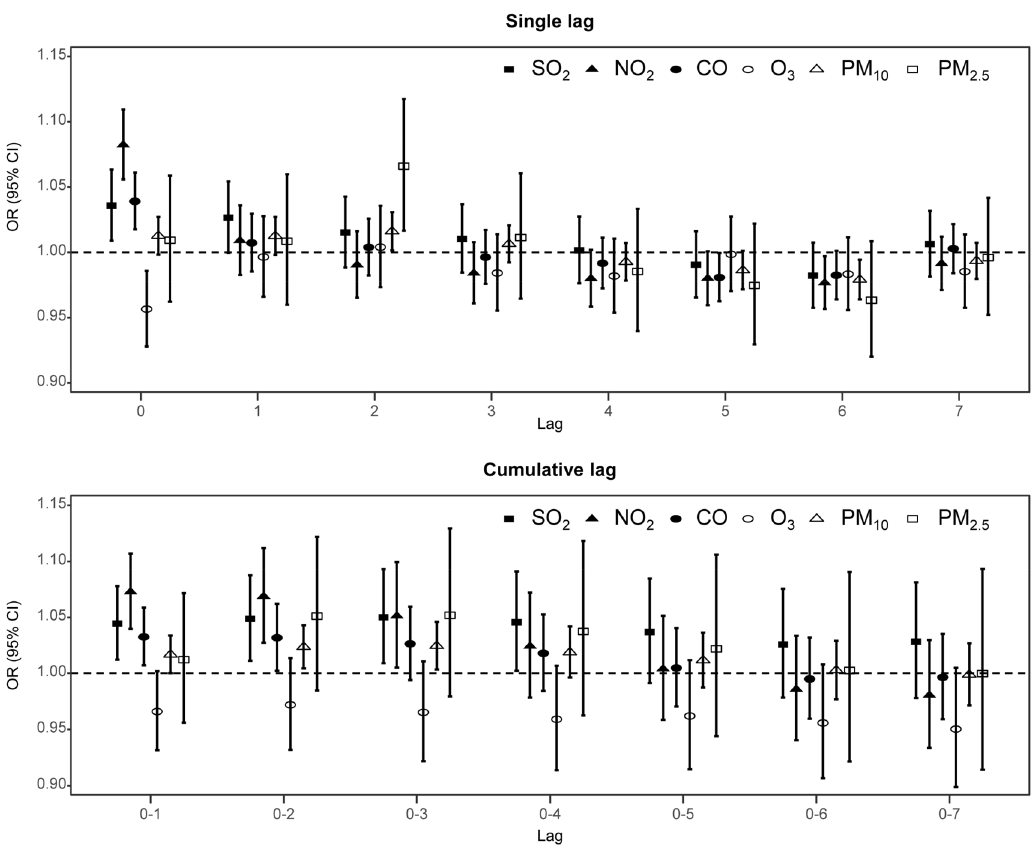
Figure 1. Association between Meniere’s disease and air pollution. The pooled effect estimates of odd ratios (ORs) and 95% CIs for Meniere’s disease hospital visits considering interquartile range increase in each air pollutant concentration are presented according to various lag structures to take into account the immediate, delayed, and cumulative effects of air pollutants. Single lag indicates exposure on the case or control day (lag0) or on day 1–7 prior to the case or control day (lag1–lag7). Cumulative lag indicates the moving average of exposure between the case or control day and ‘n’ days prior to the case or control day (lag0–n). This figure was